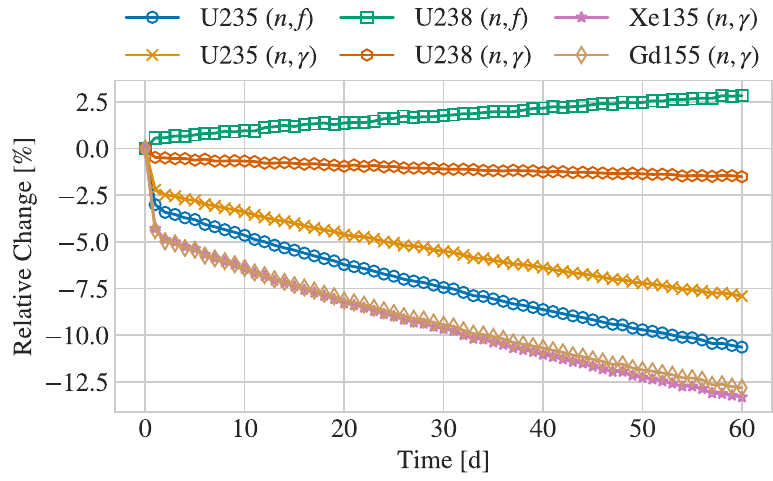
Figure 2: Relative change in microscopic cross sections for select reactions in a single